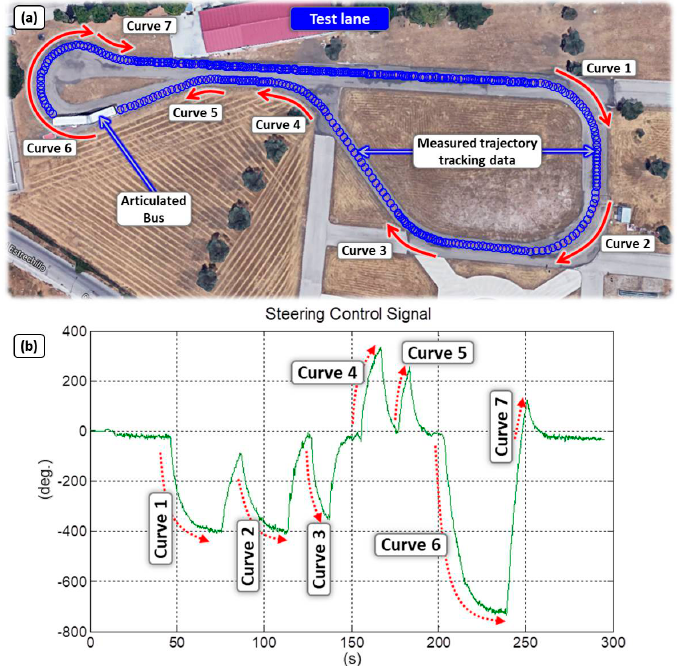
Figure 17. ( a ) Test lane and trajectory at the CSIC; ( b ) steering wheel angular value during an experiment conducted on the test lane. Appl. Sci. 2017 , 7 , 1131